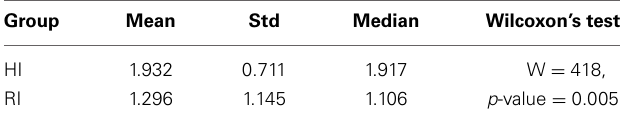
Table 1 | Reaction time (seconds) in response to robot attention stimuli (utterances) during verification phase.